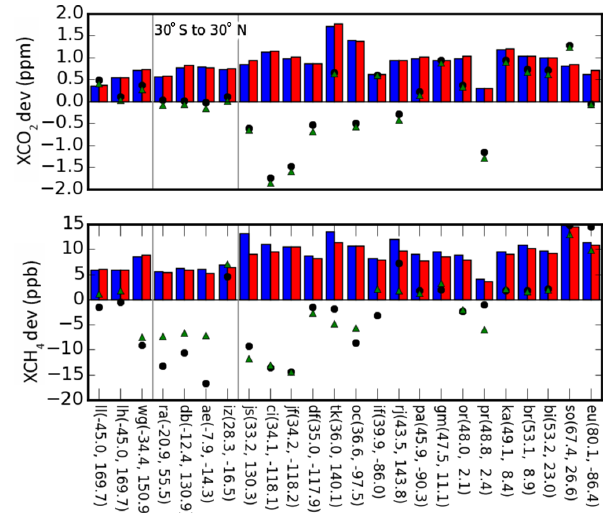
ences between TCCON (top) XCO 2 and (bottom) XCH 4 measure- ments and the a posteriori models. Blue and red bars denote the standard deviations between TCCON and the in situ and ratio a pos- teriori model, respectively. Black circles and green triangles denote the mean deviation of the TCCON and the in situ and ratio a poste- riori